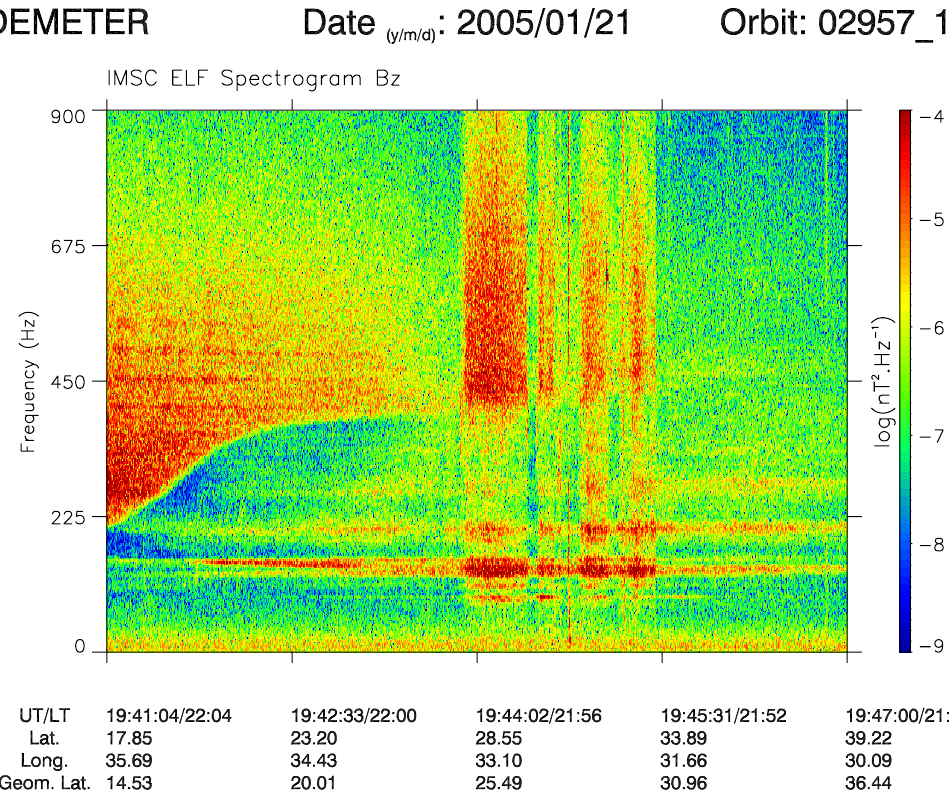
Fig. 6. Enlarged spectrogram between 0 and 900Hz related to the event shown in Fig. 5 but with the magnetic component B z